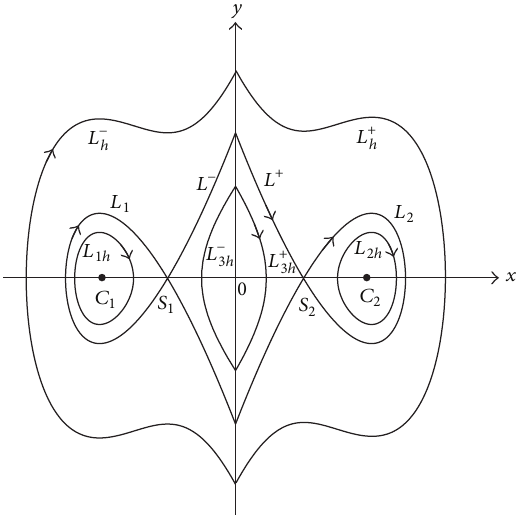
Figure 3: Phase portrait of system (1) | 𝜀=0 under